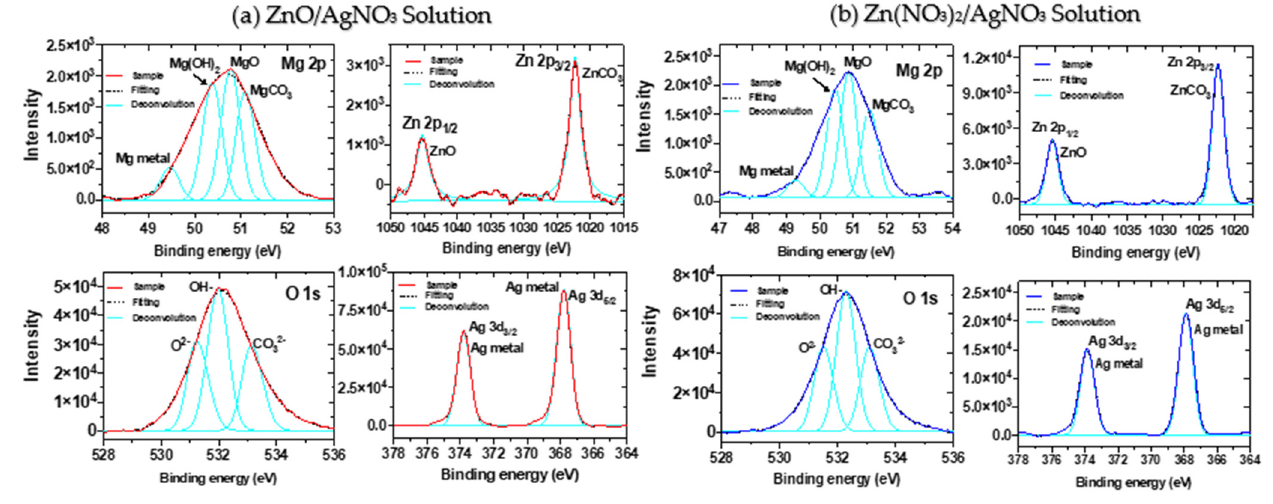
Figure 10. XPS spectra of ZnO/Ag hybrid deposits on Mg-Ca0.3 surface, electroless achieved from aqueous solutions (10 − 3 M, at 21 °C): ( a ) ZnO/AgNO 3 and ( b ) Zn(NO 3 ) 2 /AgNO 3 solutions.